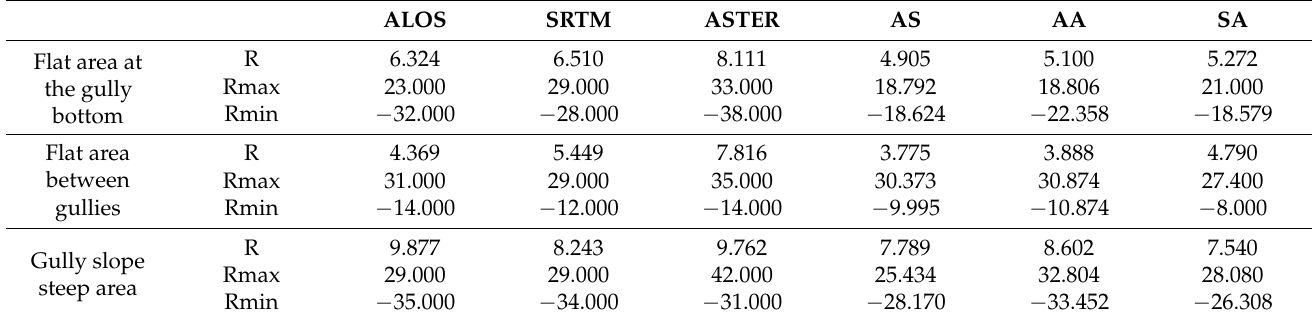
Table 7. The error statistical value of partition-weighted fusion in Shenmu (unit: m). ALOS SRTM ASTER AS AA SA